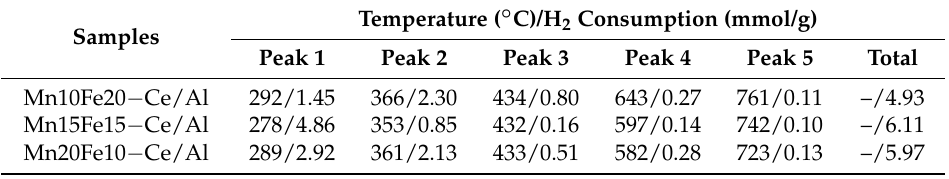
Table 3. Quantitative analysis of H 2 -TPR profiles.